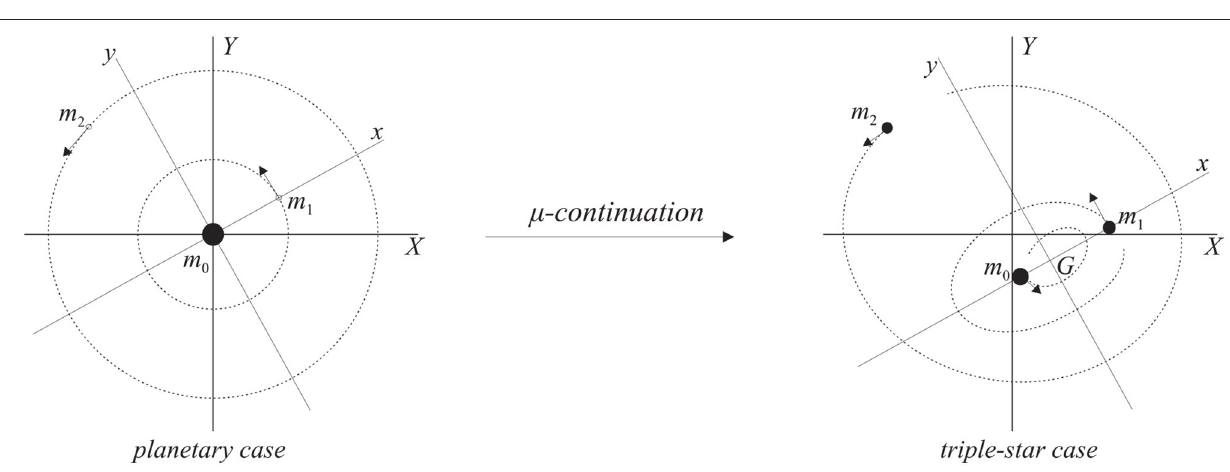
eccentricity remains < 0.01. All orbits of S ( µ ; a 0 ) are